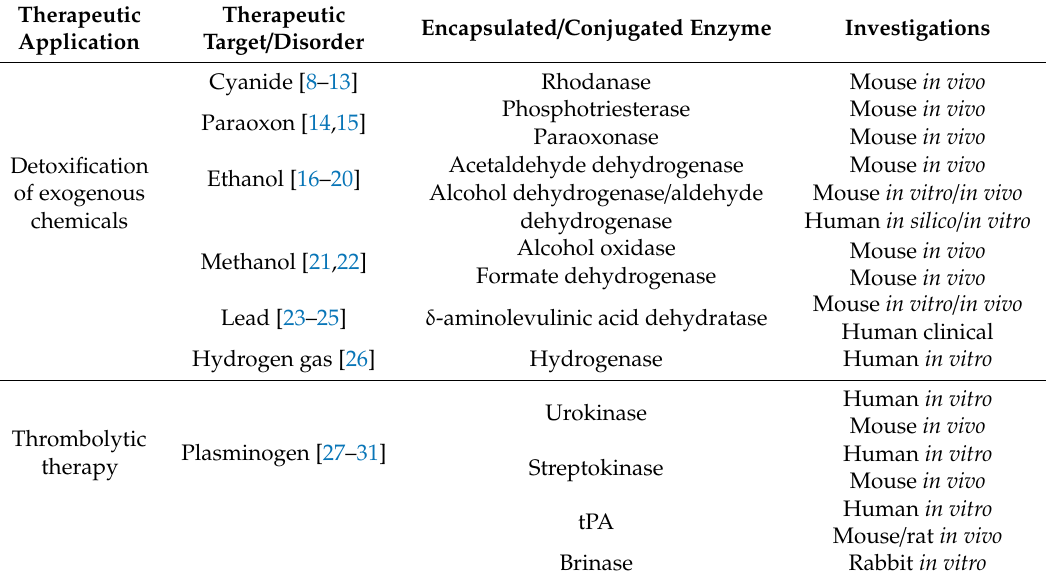
Table 1. Summary of in vitro , in vivo and clinical applications of erythrocyte-mediated enzyme